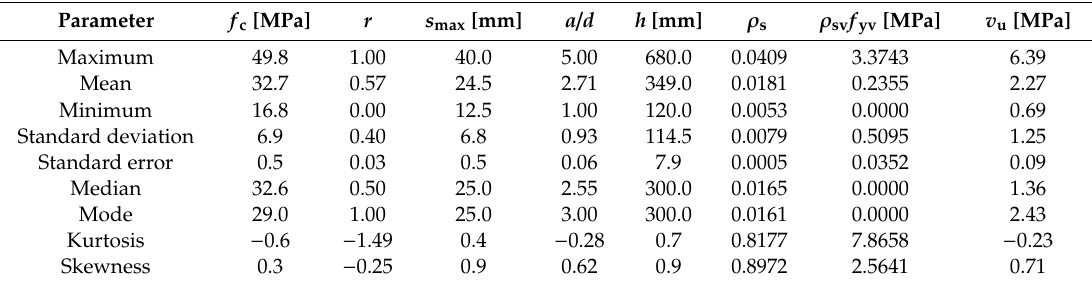
Table 1. Statistics of parameters in the